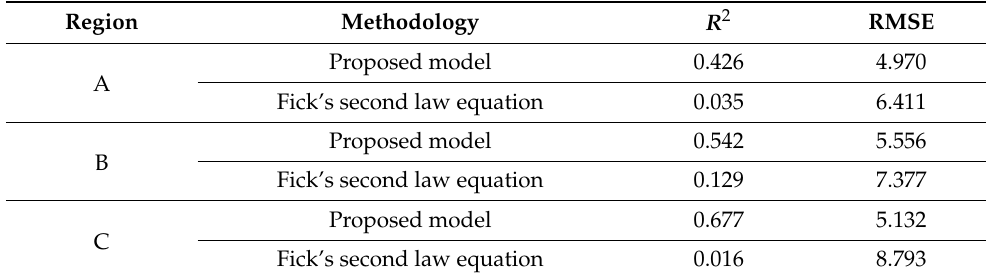
Table 6. LSTM model layer for the carbonation model.